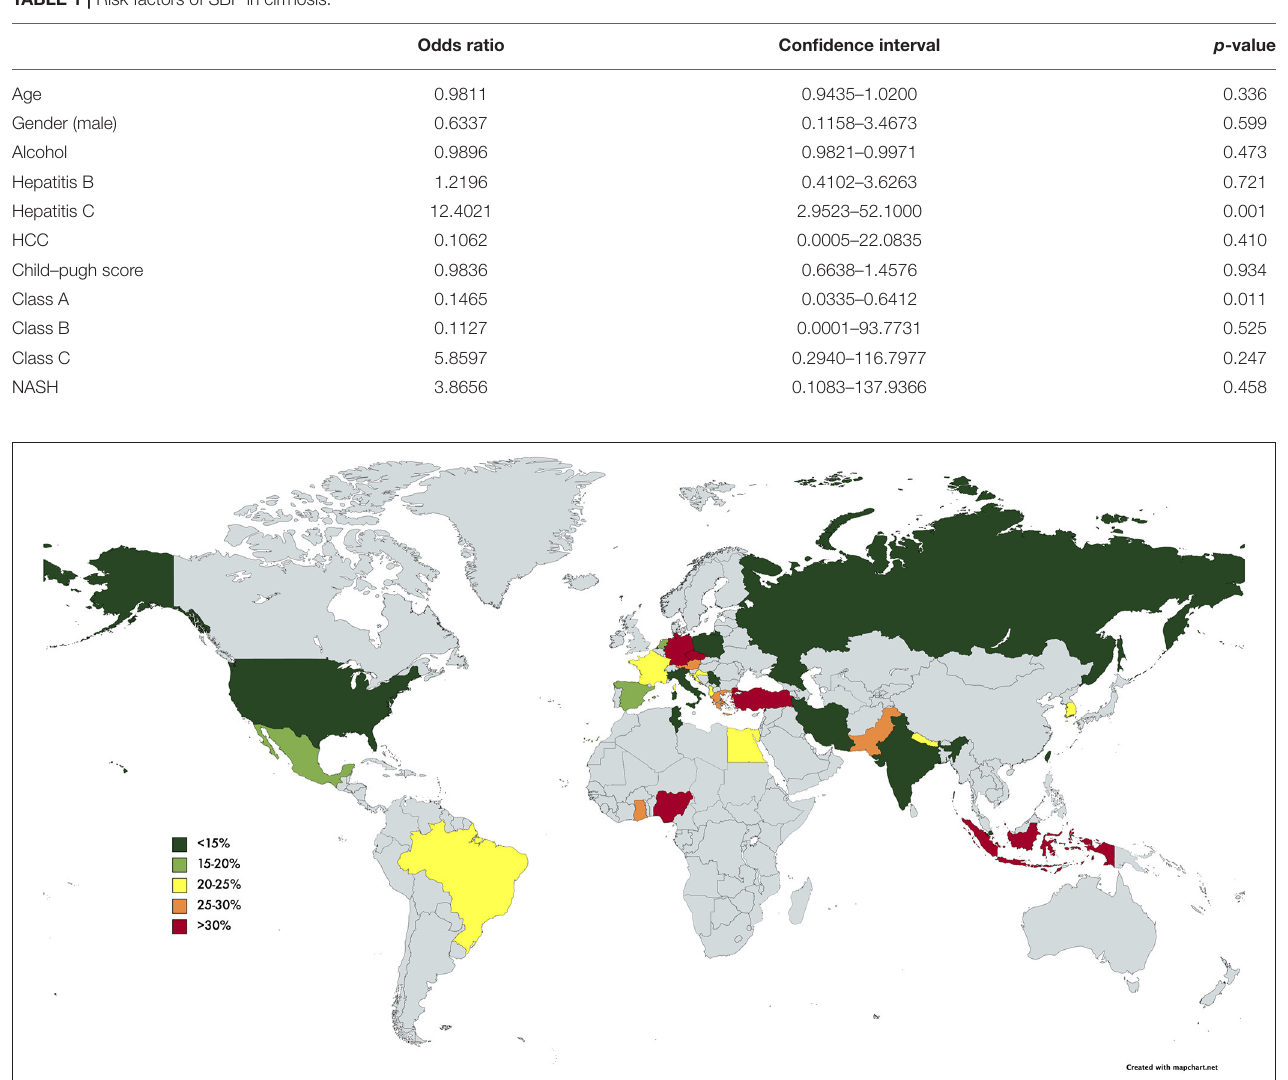
TABLE 1 | Risk factors of SBP in cirrhosis.